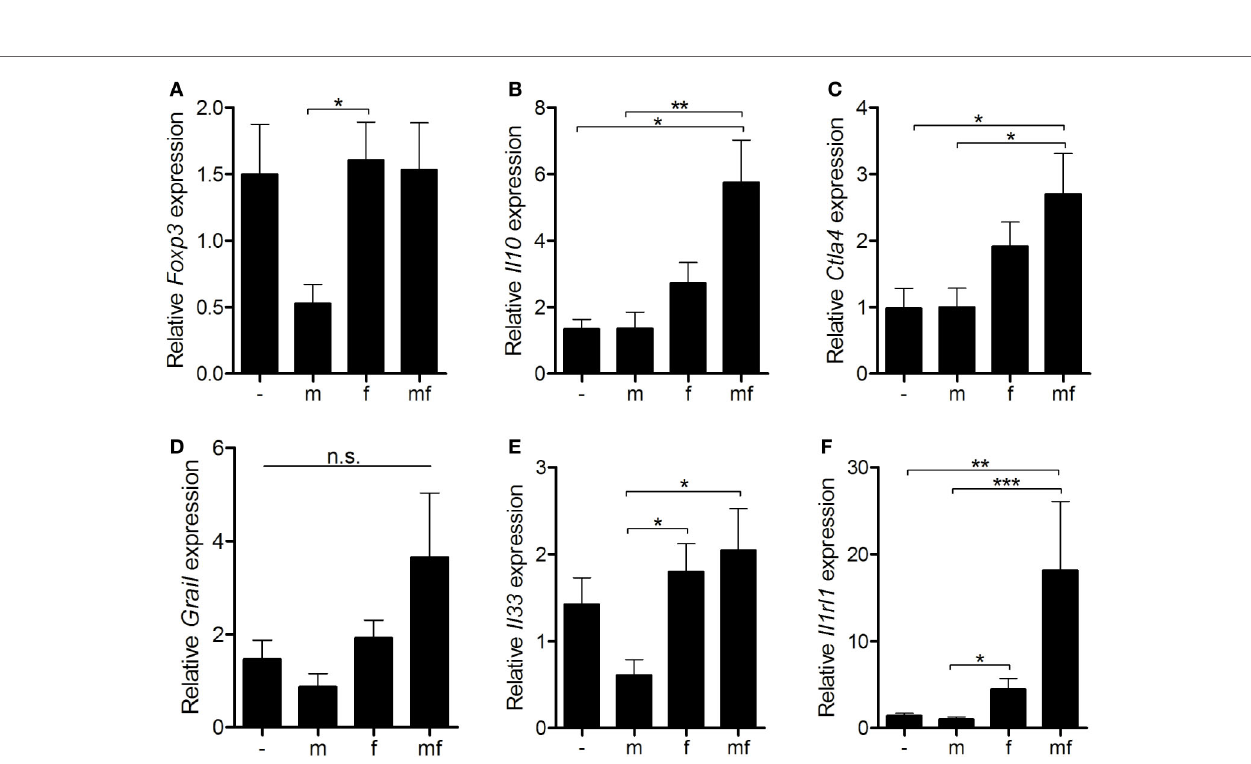
FigUre 4 | Female schistosomes upregulate anergy-related gene expression. Six weeks p.i. relative expression of (a) Foxp3 , (B) Il10 , (c) Ctla4 , (D) Grail , (e) Il33 , and (F) Il1rl1 in spleens was determined by real-time PCR. Data are presented as mean + SEM; n = 10–11 mice each group; * p < 0.05, ** p < 0.01, *** p < 0.001, n.s., not significant.